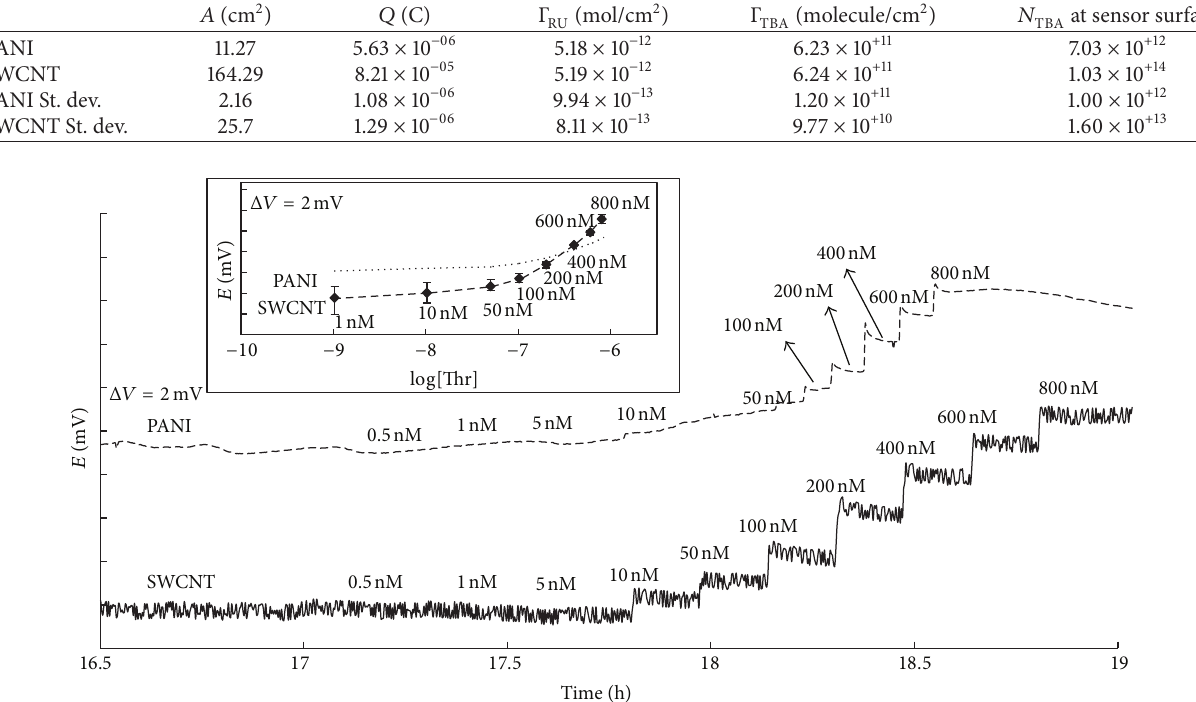
Table 1: Calculated surface charge and ligand density values with the corresponding standard deviations ( 𝑁 = 3 ). 𝐴 (cm 2 ) 𝑄 (C)